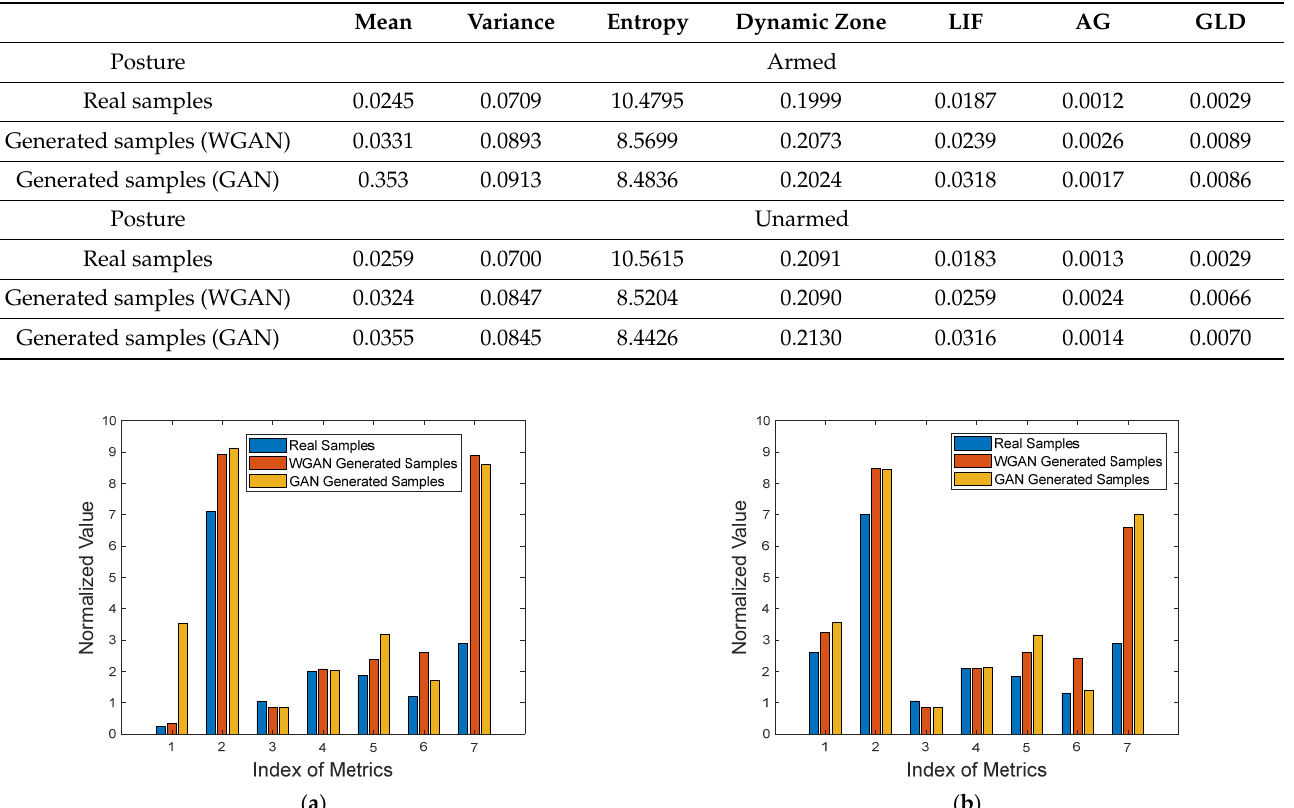
Table 4. Values of the seven evaluation metrics of the generated samples from the database based on the modified Boulic model.